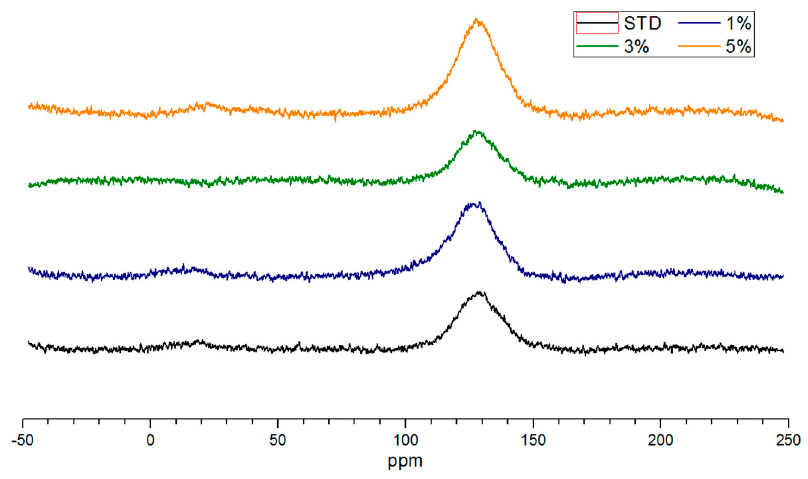
Figure 11. The NMR result of biochar pyrolyzed at 500 °C before and after flushing.